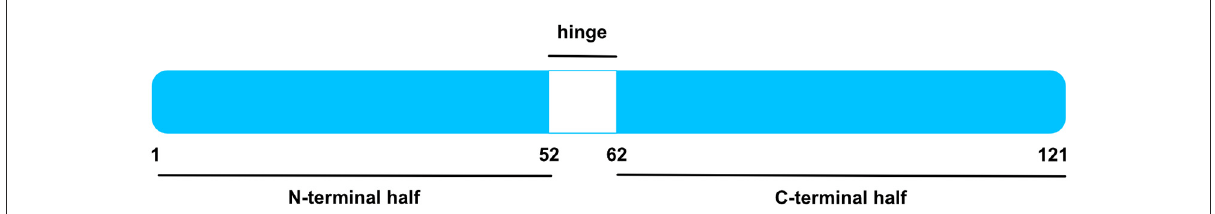
FIGURE1 Human MK Protein. Schematic illustration of human MK protein, after signal sequence cleavage. MK is compiled by an N-terminal and a C-terminal half, signified by blue boxes. Whereas, the former entails the N-tail (aa 1–14) and N-domain (aa 15–52), the latter is composed by the C-domain (aa 62–104) and C-tail (aa 105–121). The hinge region in white (aa 53–61) connects both domains. The C-domain contains several heparin-binding sites. Figure was adapted from Weckbach et al. (14).